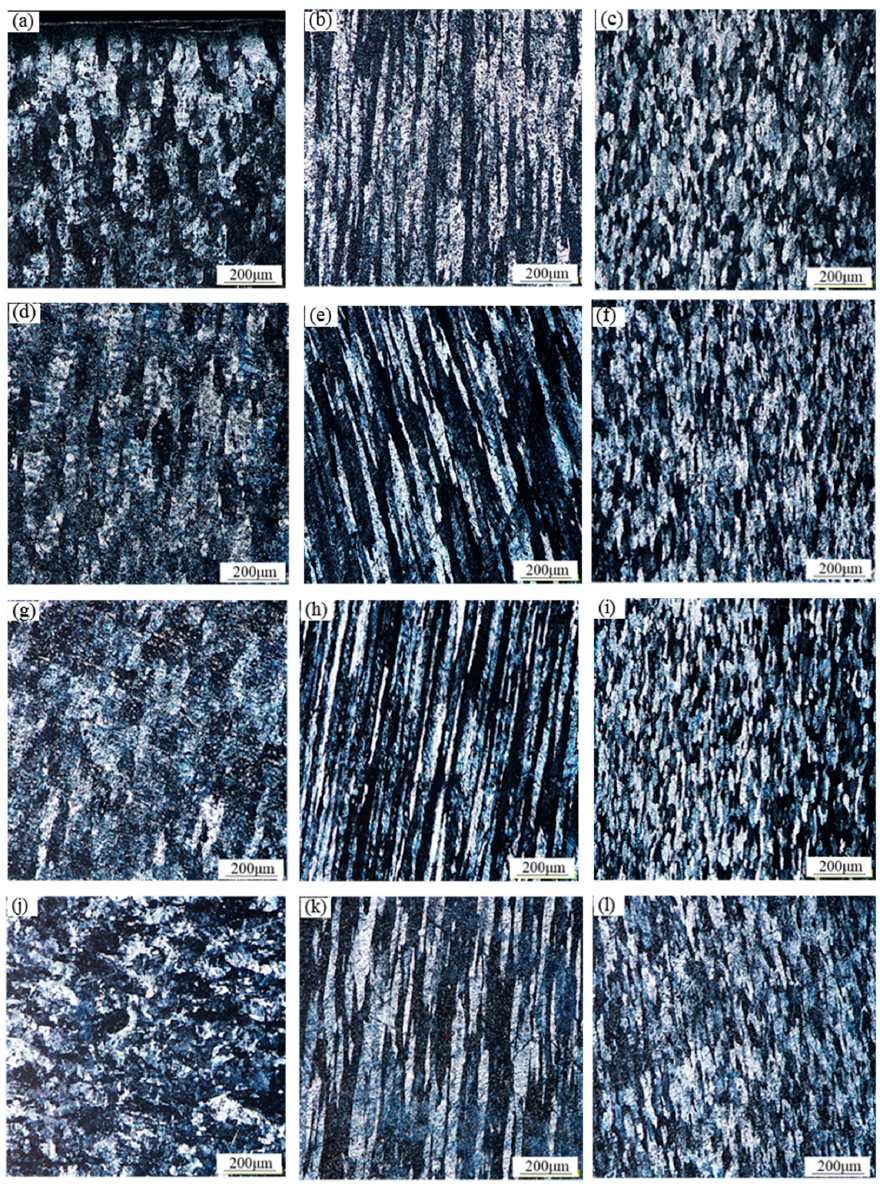
Figure 3. Grain microstructure of the 1060 aluminum alloy cast rolling strips: ( a–c ) the top surface, longitudinal section, cross section of the strip with added 0.18 wt% Al-Ti-B refiner and applied conventional treatment; ( d–f ) the top surface, longitudinal section, cross section of the strip with added 0.18 wt% Al-Ti-B refiner and applied ultrasonic treatment; ( g–i ) the top surface, longitudinal section, cross section of the strip with added 0.12 wt% Al-Ti-B refiner and applied ultrasonic treatment; ( j–l ) the top surface, longitudinal section, cross section of the strip with added 0.09 wt% Al-Ti-B refiner and applied ultrasonic treatment.